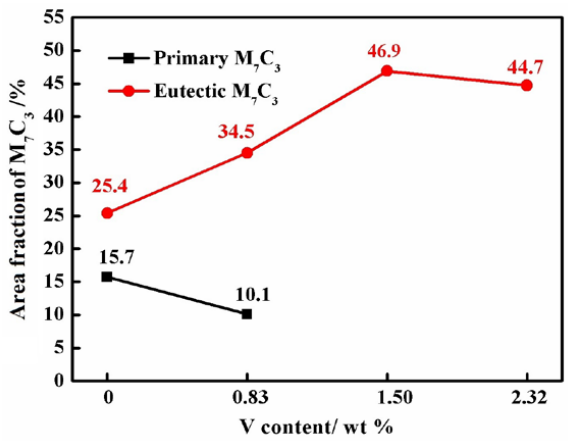
Figure 12. Area fraction of M 7 C 3 carbides in different HCCI hardfacing layers.